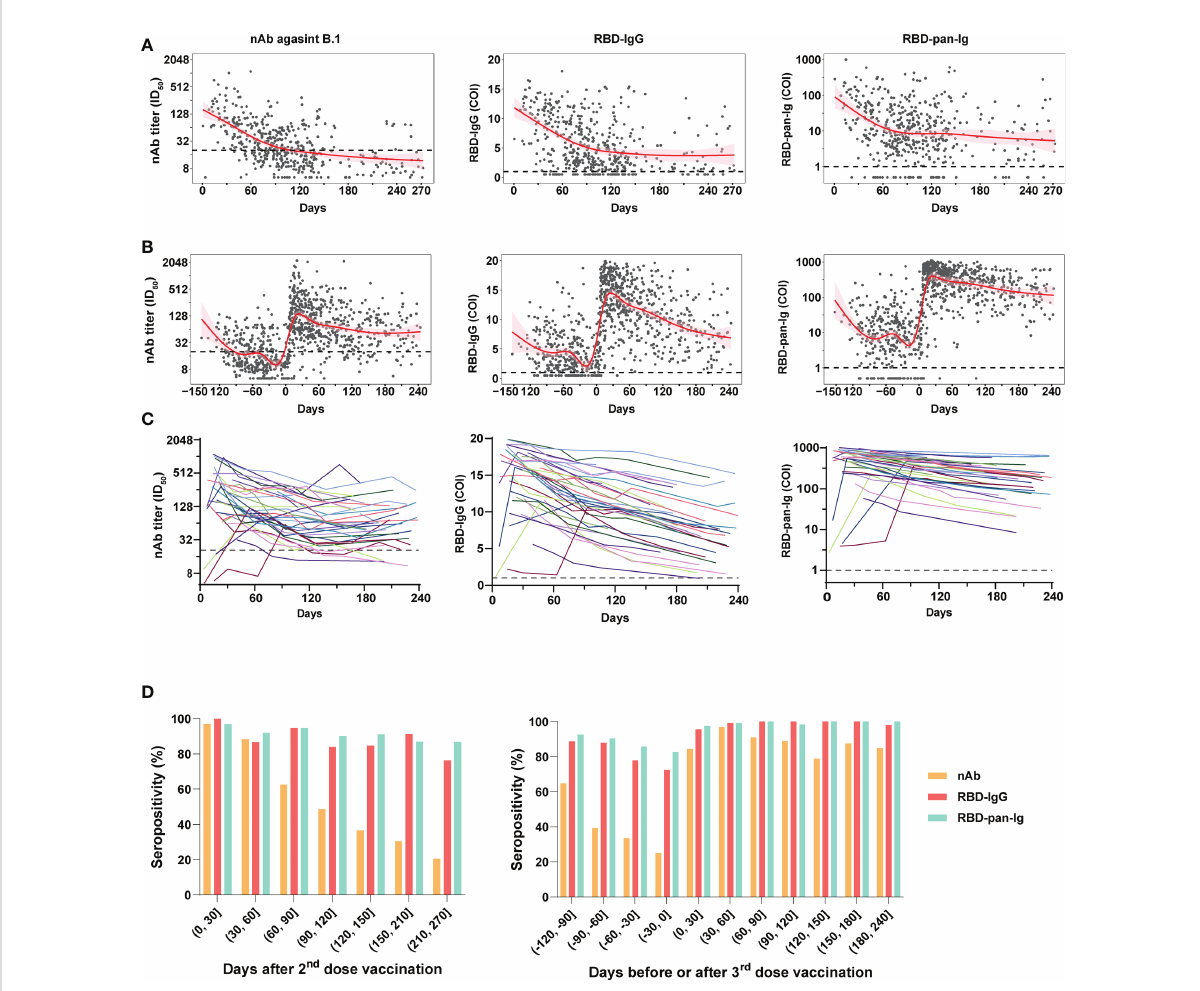
FIGURE 2 Dynamic changes of antibody response in blood donors with two- or three-dose inactivated COVID-19 vaccines. (A, B) The kinetics of the nAb (left panel), RBD-IgG (middle panel), and RBD-pan-Ig (right panel) titers in the 2-dose group (A) and 3-dose group (B) following the time since the last immunization. The 95% con fi dence intervals of the fi tting curves are plotted as red-shaded areas. The broken blue lines represent the cutoff values. (C) Longitudinal changes of antibody titers in 37 individuals of the 3-dose group who donated their blood ≥ 4 times after the 3 rd dose immunization. Each line represents a connected line of antibody levels measured at different time points of the same donor. Dark shadows indicate the limits of detections (LODs). (D, E) The seropositivities of three antibody markers (indicated by columns with different colors) in the study populations following days since the 2 nd (D) or the 3 rd (E) dose vaccination. COI, cutoff index; ID 50 , half-maximal inhibitory